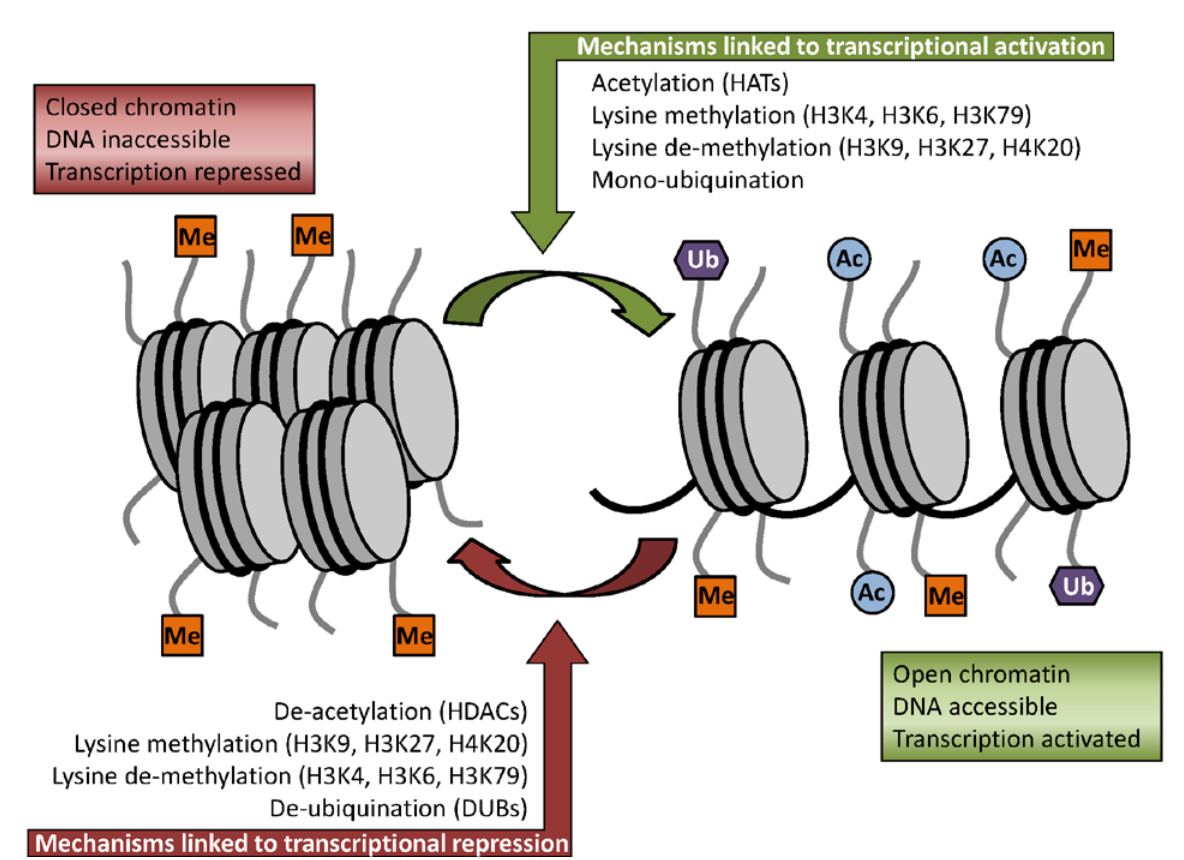
Figure 1. Some of the key histone modifications influencing gene expression. On the left is a representation of closed chromatin, in which the DNA is inaccessible to the transcriptional machinery and transcription is therefore repressed. Modifications to specific histone residues such as the addition of an acetyl group to a lysine residue (via a histone acetyl transferase, or HAT) lead to unfolding of the chromatin (as shown on the right hand side of the figure), which in turn allows the transcriptional machinery to access the DNA, resulting in transcriptional activation. Conversely, removal of this acetyl moiety (through a histone deacetylase, or HDAC) alters the histone configuration, once more returning the chromatin to the closed form. In the case of histone methylation, the effect on chromatin conformation depends on the specific lysine residue being methylated (as